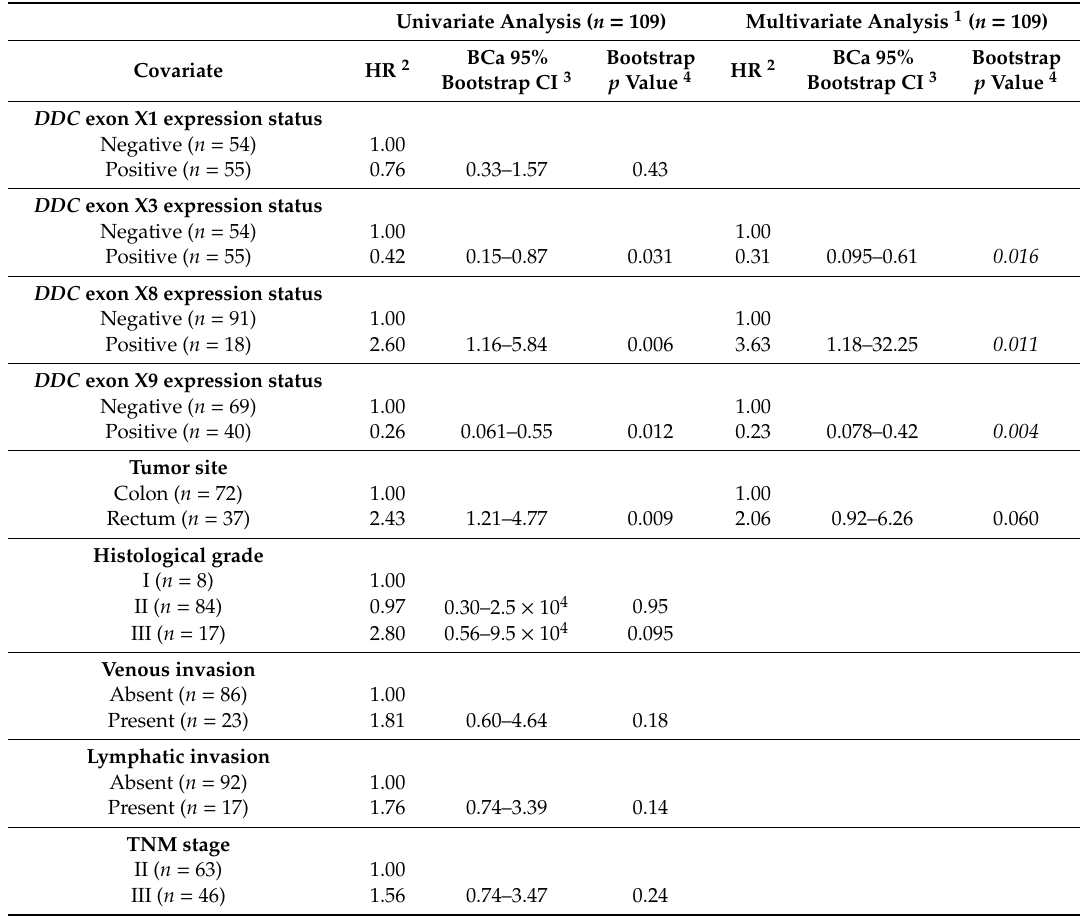
Table 4. Expression status of DDC novel exons and OS of CRC